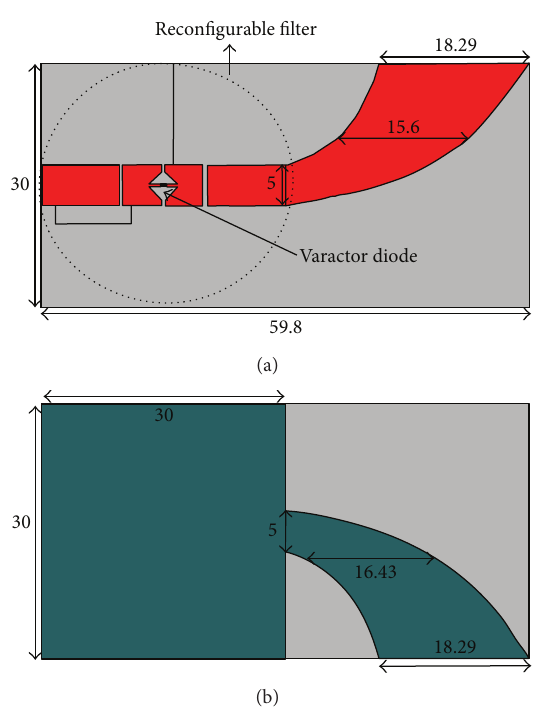
Figure 22: Frequency reconfigurable filtenna: (a) top layer and (b) bottom layer